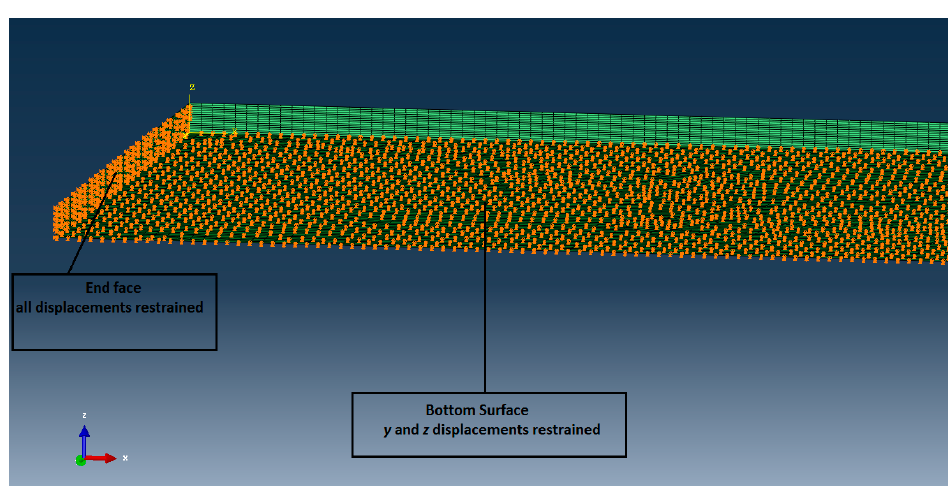
along the x-axis, i.e., along the load direction. The boundary conditions are shown in Fig-